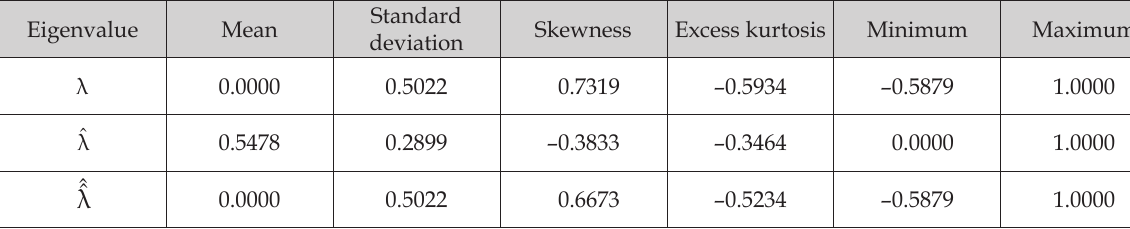
Table A2. Summary statistics for Polish voivodeship eigenvalues estimation